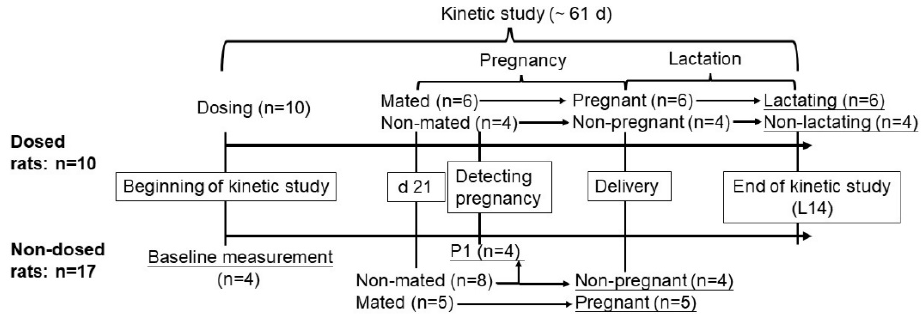
Figure 1. Study design for the VA kinetic study. The upper arrow represents the timeline for the dosed rats ( n = 10), and the lower arrow represents the timeline for non-dosed rats ( n = 17). Underlines indicate the time of euthanasia. P1, pregnancy day 1; L14, lactation day 14.